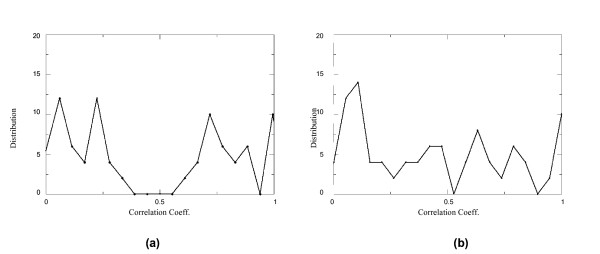
Correlation coefficient distribution between all pairs of conformational clusters at 450 K. The figure displays the distribution of correlation coefficients between all the pairs of conformational clusters in the simulations of PrP (a) and Dpl (b) at 450 K.